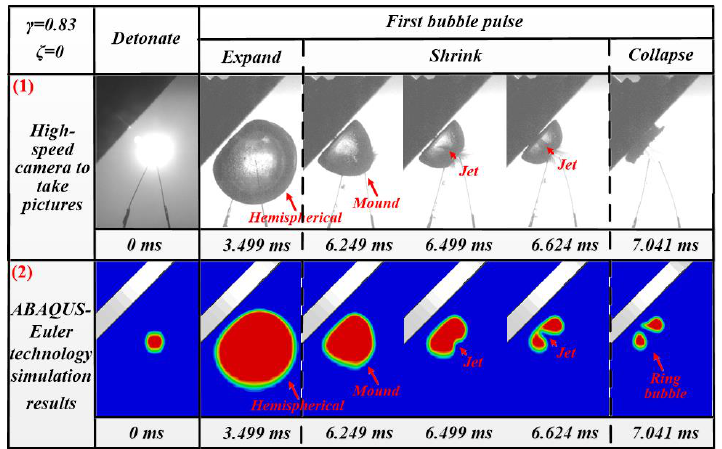
Figure 10. Comparison of experimental results and simulation results. ( 1 ) The pulsation diagram of the first cycle of the bubble taken by a high-speed camera. ( 2 ) The pulsation diagram of the first cycle of the bubble simulated by ABAQUS/Explicit.